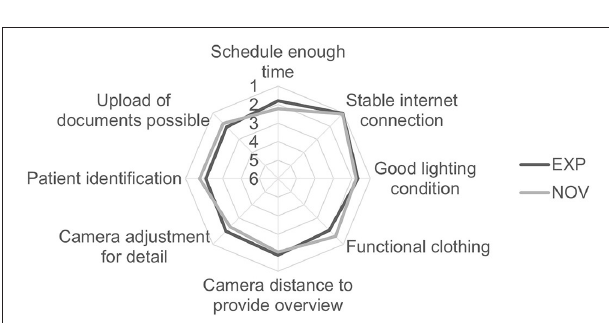
FIGURE 3 | Results of the assessment of the perceived relevance of each individual illustration (rating according to the German School grading system from “1 – very good” to “6 – Insufficient”) (EXP n = 30, NOV n =